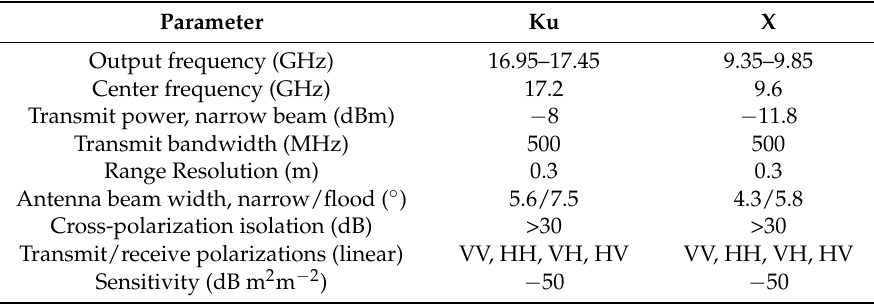
Table 2. UWScat system